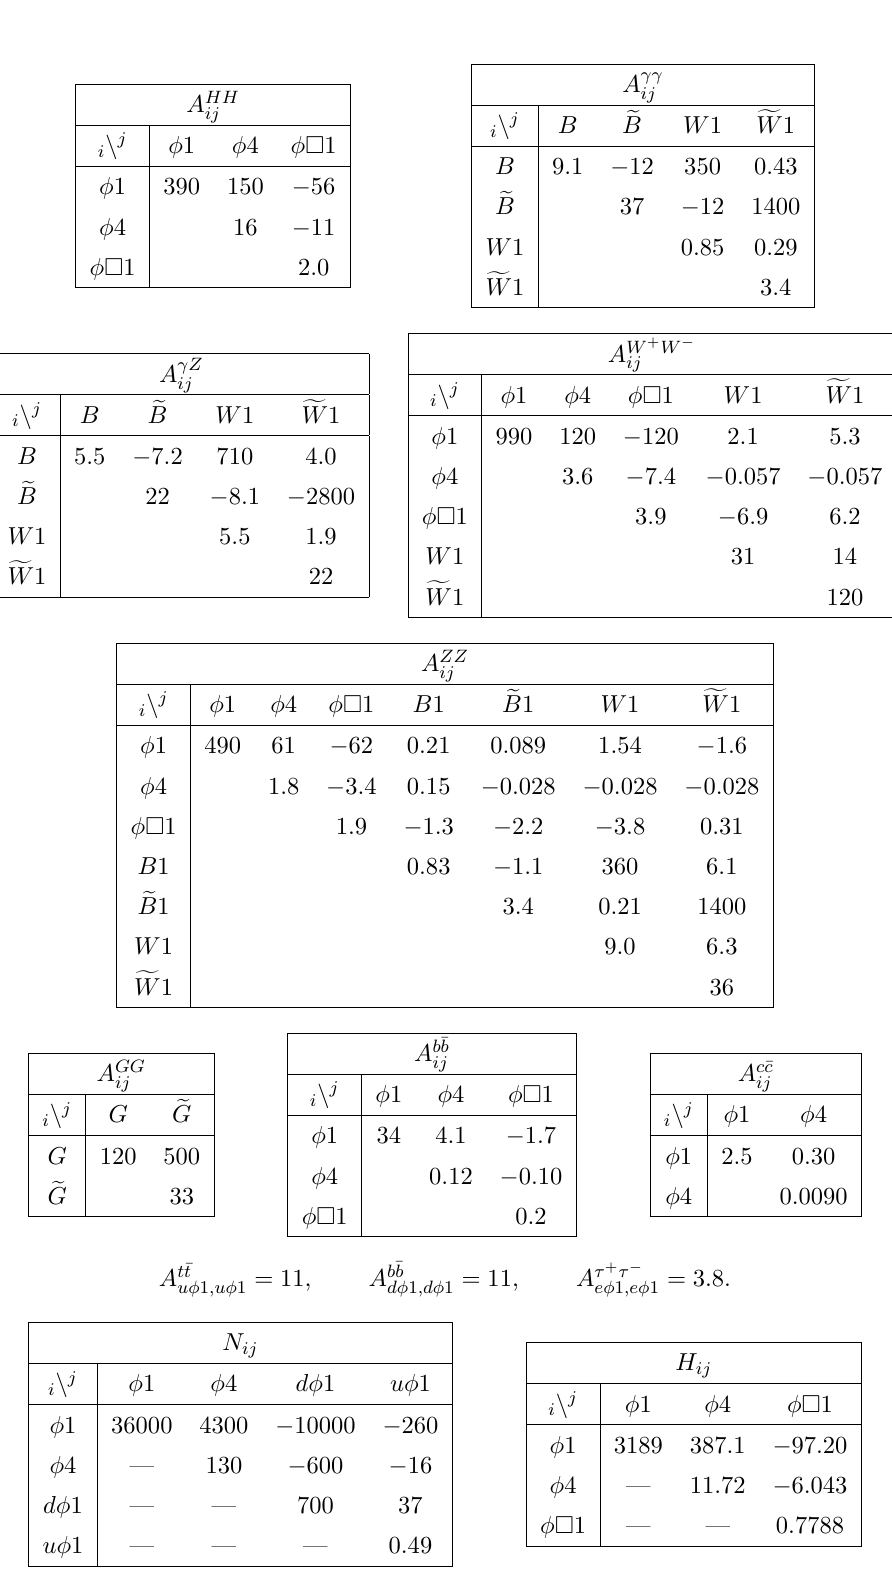
Table 2 . Coefficients A fg cross section, DM-nucleon scattering cross section and Higgs to invisible branching